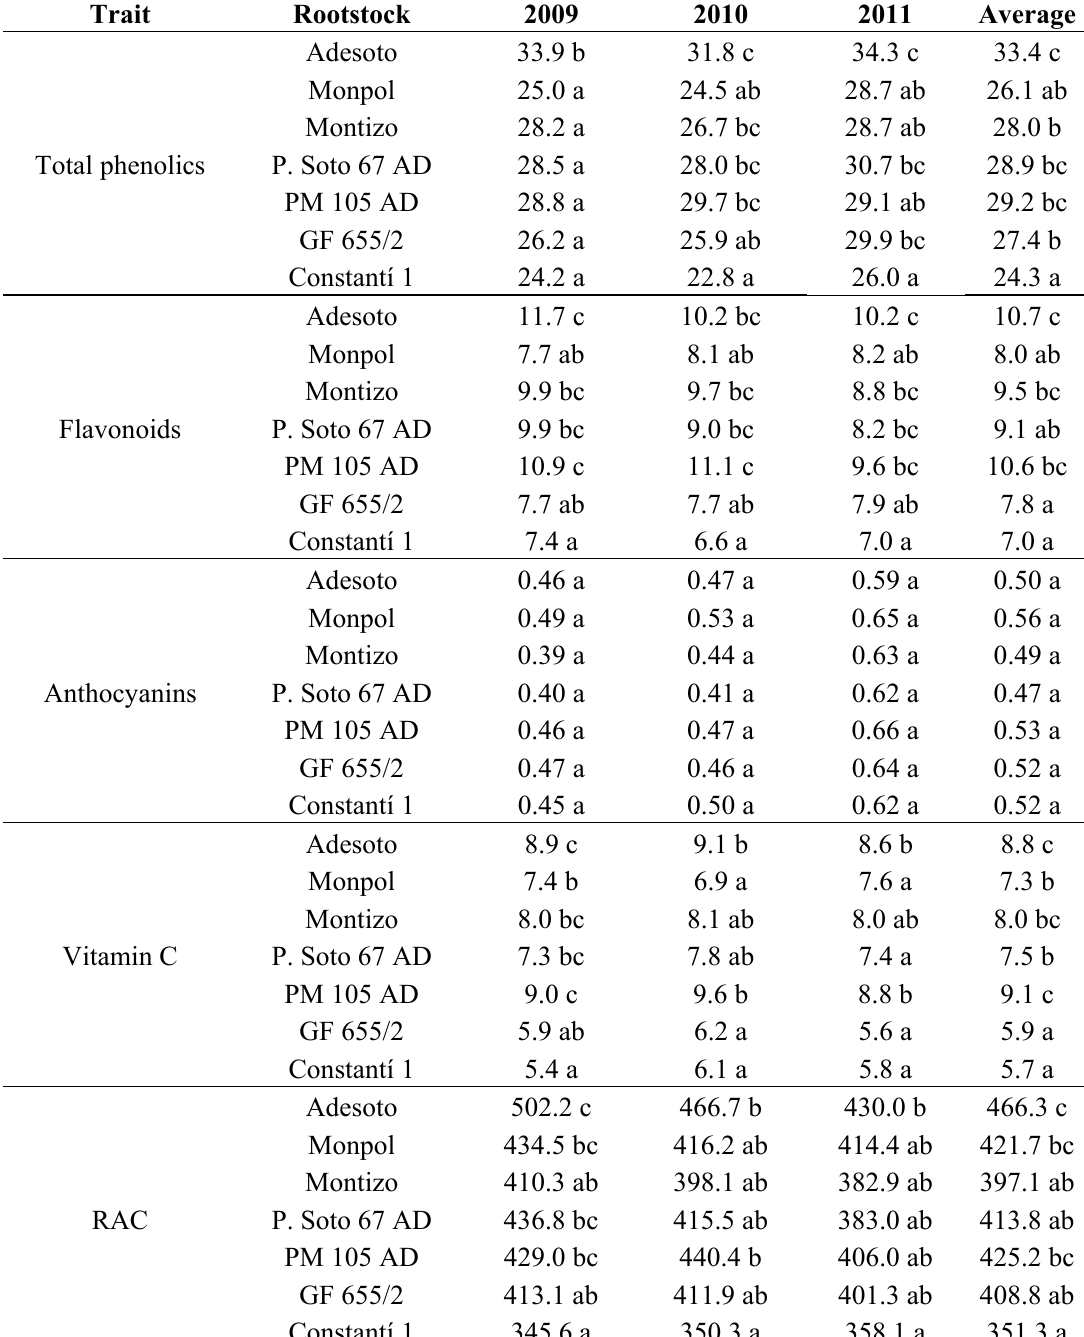
Table 4. Influence of different plum rootstocks on the antioxidant compounds of “Catherine” peach fruits in the tenth (2009), eleventh (2010) and twelfth (2011) year after